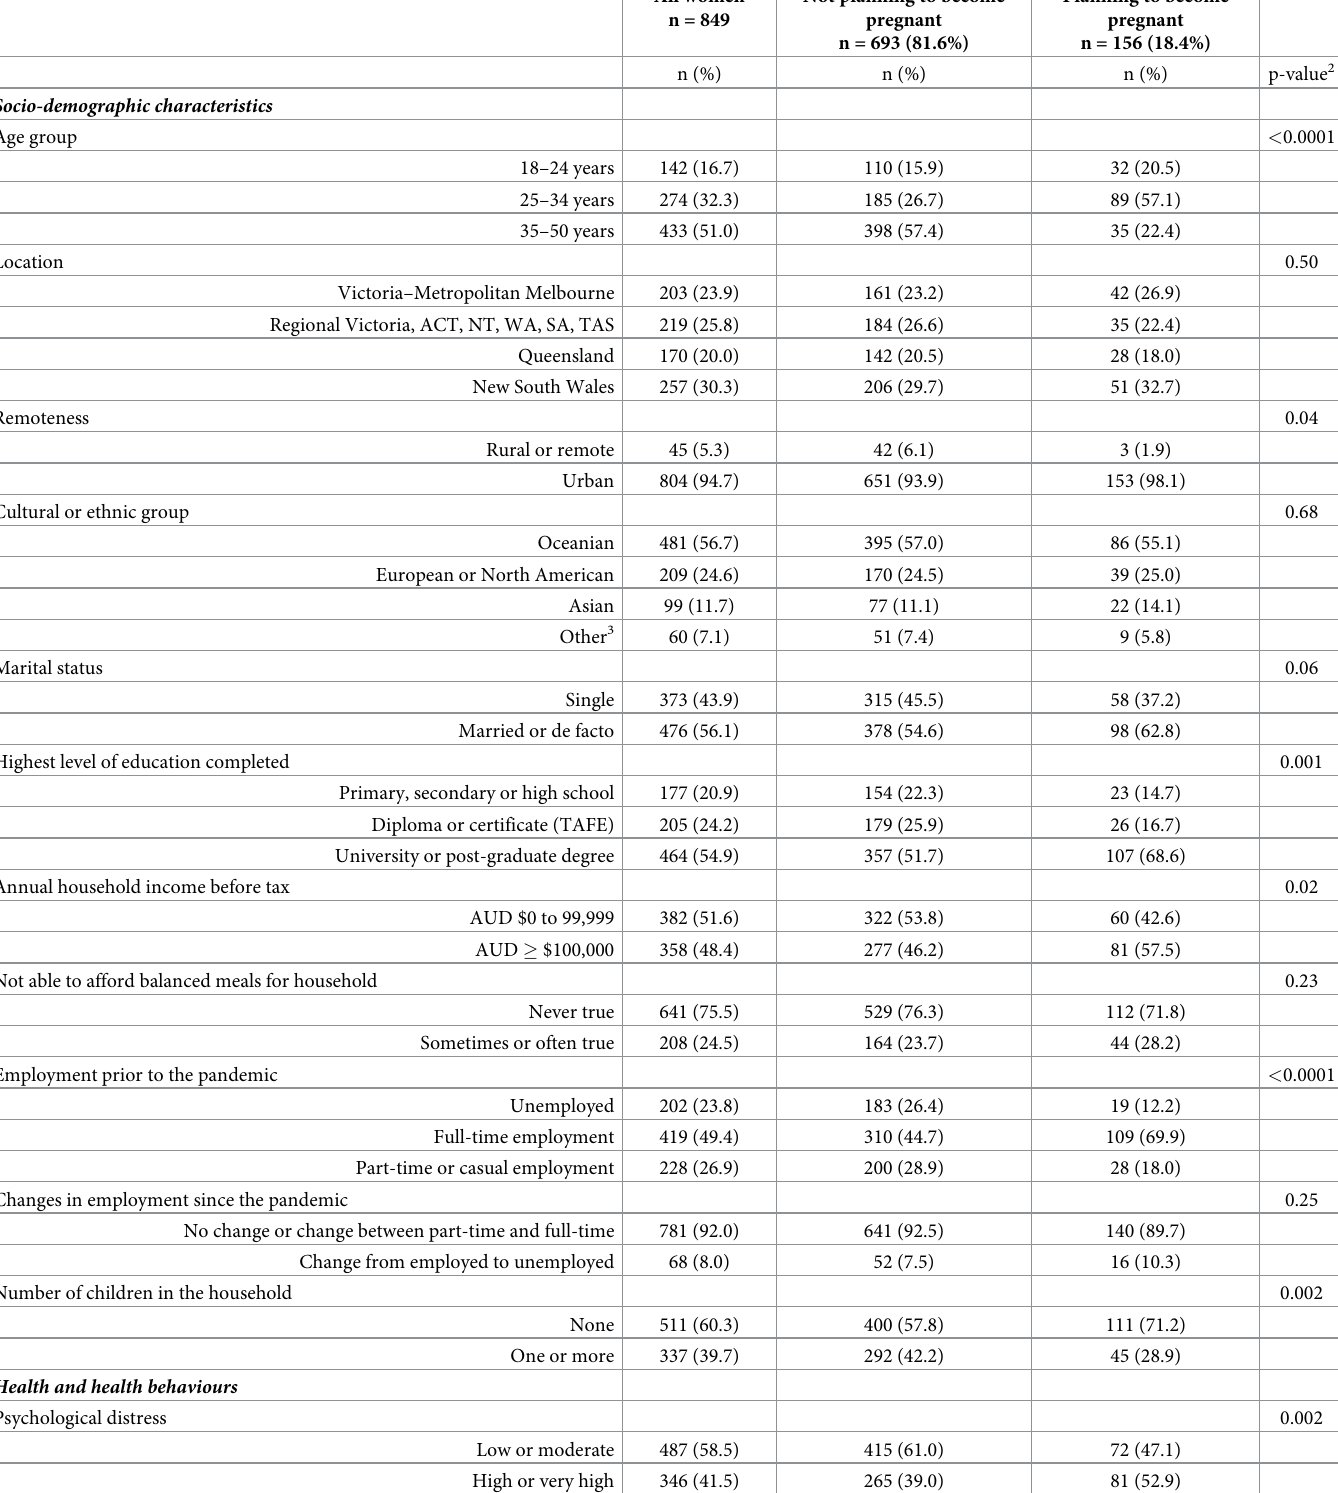
Table 1. Participant characteristics overall and according to pregnancy intention, n = 849 1